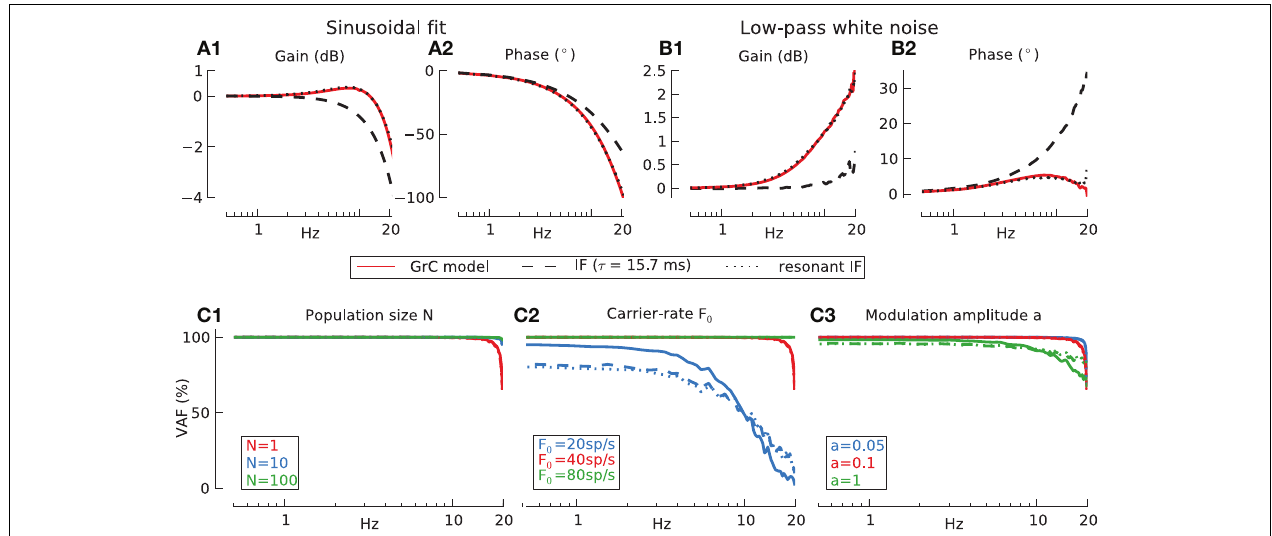
FIGURE 3 | Information transmission by model GrC in response to modulated current injection, assessed by two methods. Baseline conditions for all following simulations: population size N = 1, carrier-rate F 0 = 40 spikes/s, modulation amplitude a = 0 . 1. (A) Sinusoidal fitting. Transfer function gain (A1) and phase (A2) for detailed GrC model (red lines), passive integrate-and-fire (IF) neuron (dashed lines) and resonant integrate-and-fire neuron (rIF) (dotted lines) under current stimulation. (B) Sampling rate filter for 20Hz low-pass filtered white noise. Transfer function gain (B1) and phase (B2) for three neuronal models (legend as in A ). (C) Reconstruction quality (VAF) for different neuron models under varying conditions. Legend for all panels: solid